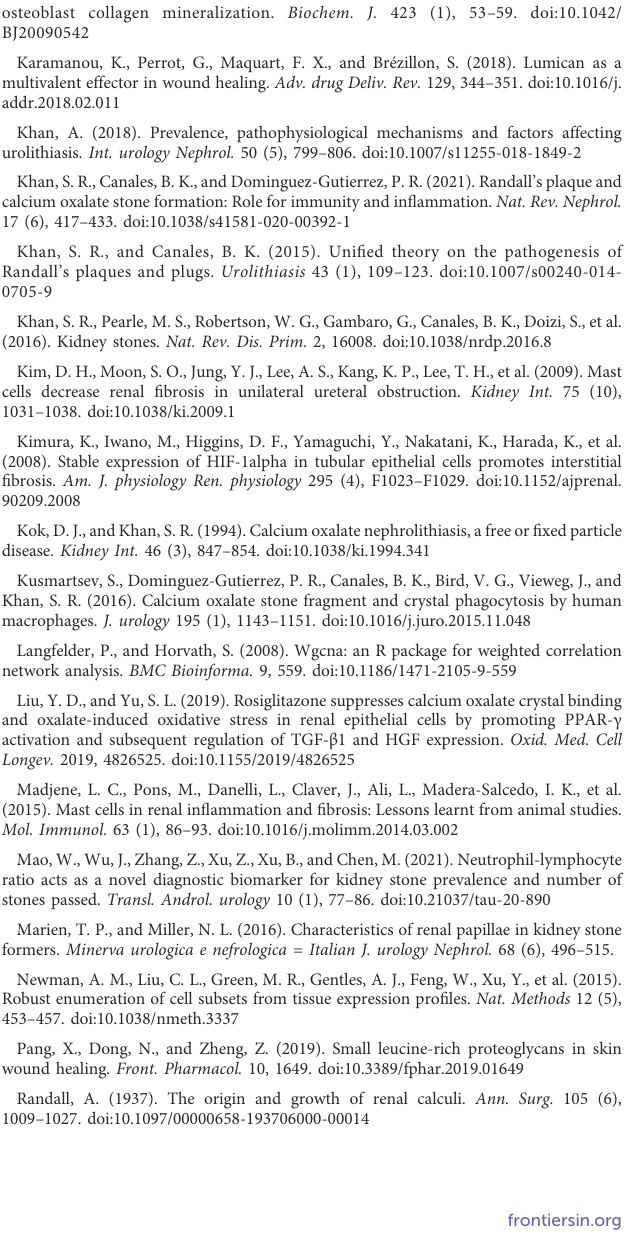
SUPPLEMENTARY FIGURE S1 Randall ’ s plaque formation in the renal papillae of